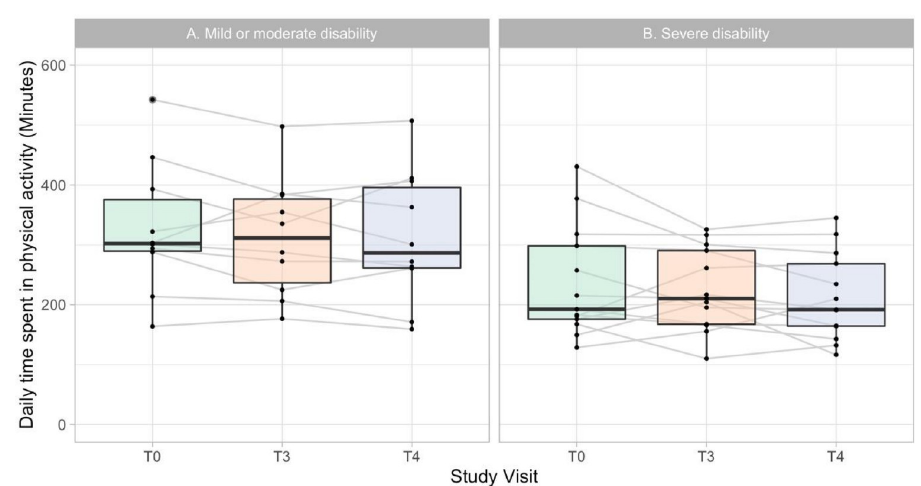
Fig 3. Median daily physical activity before and after rehabilitation. (A) Participants with mild to moderate walking disability, defined as Expanded Disability Status Scale (EDSS) less than or equal to 5. (B) Participants with severe walking disability, defined as EDSS greater than 5. T0: the week prior to rehabilitation; T3: the week following rehabilitation, T4: 3-month follow-up.